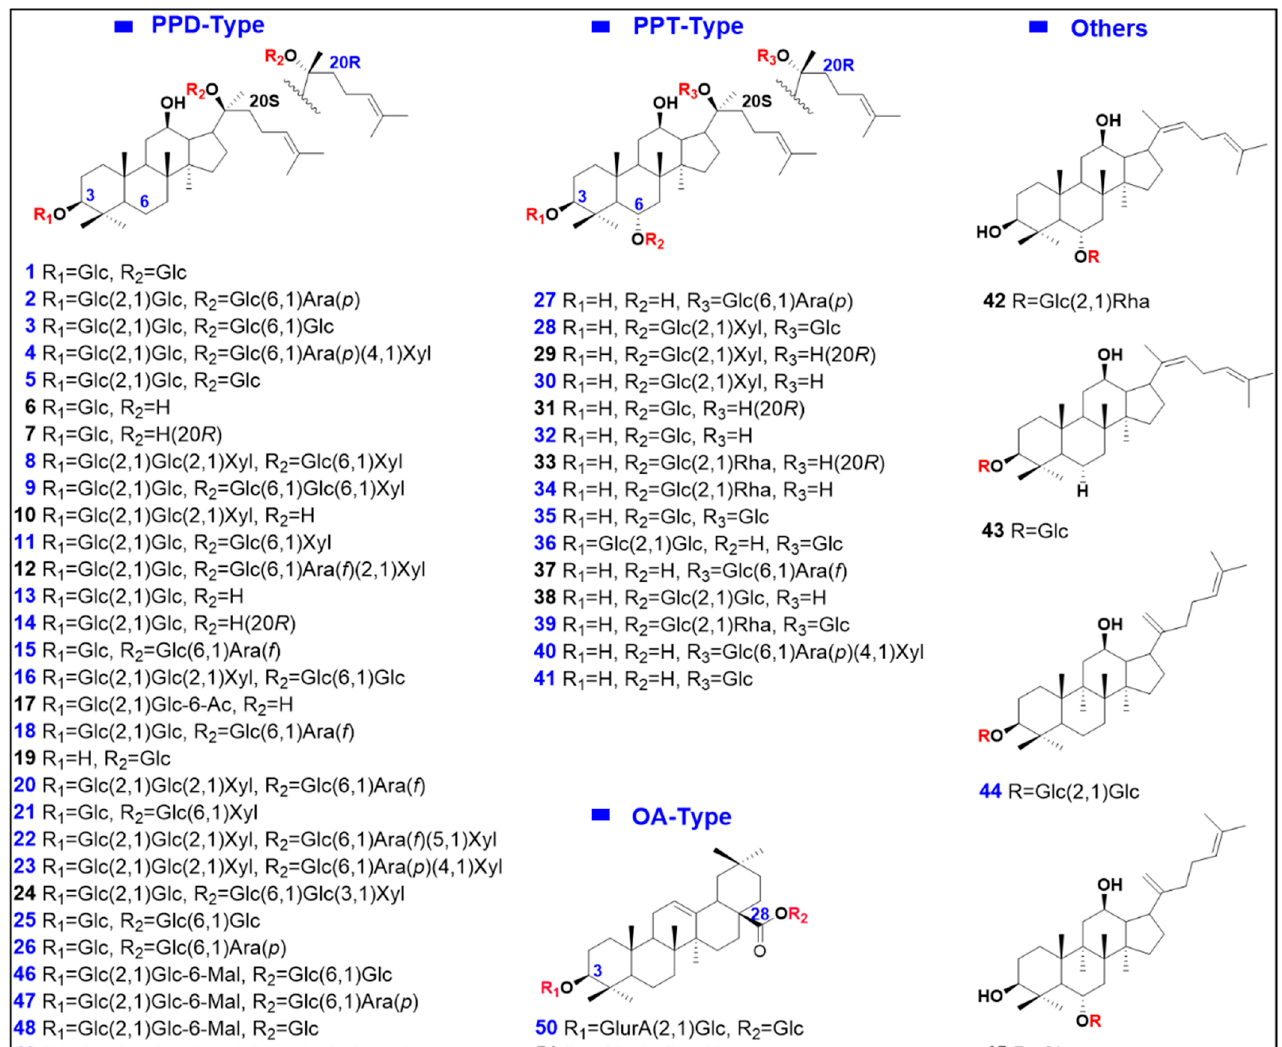
Figure 2. Chemical structures of 51 reference compounds of ginsenosides (the components identified from the PNF extract by comparison with reference compounds are marked with the numbers in bule).